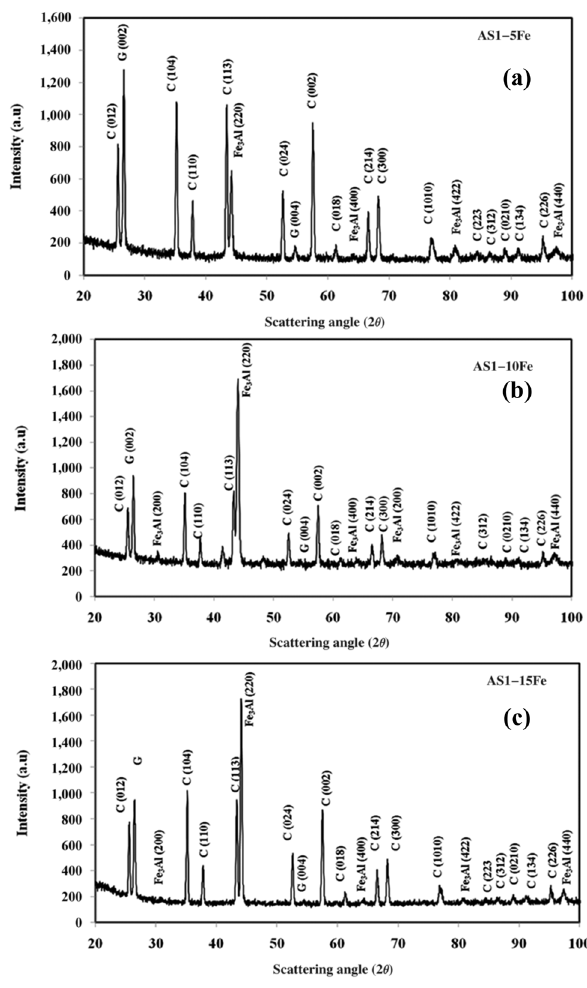
Figure 8: XRD pattern of refractory pellets [(a) AS1 – 5Fe, (b) AS1 – 10Fe and (c) AS1 – 15 Fe] after heat treatment at 1,823 K for 30 min showing Fe 3 Al as reaction product other than corundum (C) and carbon